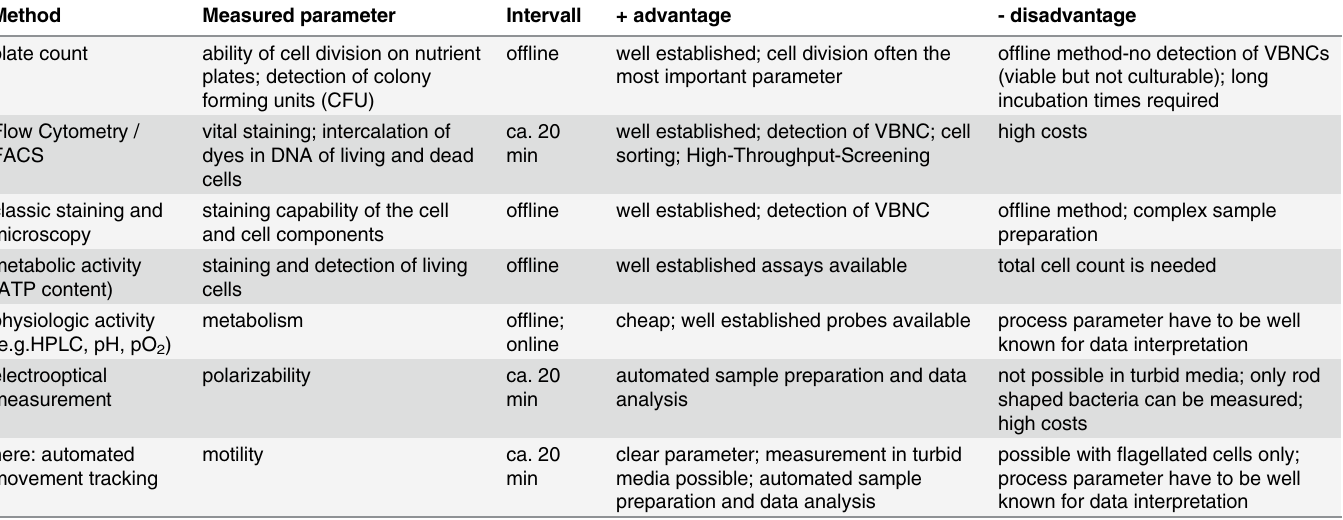
Table 1. Comparison of current viability measurement